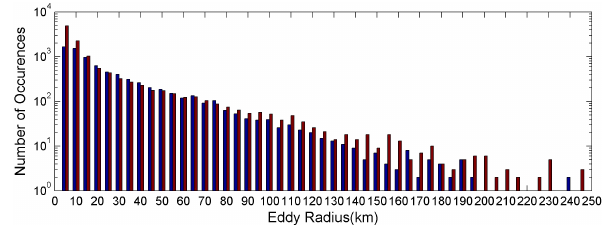
Figure 6. Histogram of eddy occurrence with a bin width of 5km as eddy radius. Blue and red bars indicate cyclonic and anticyclonic eddies,